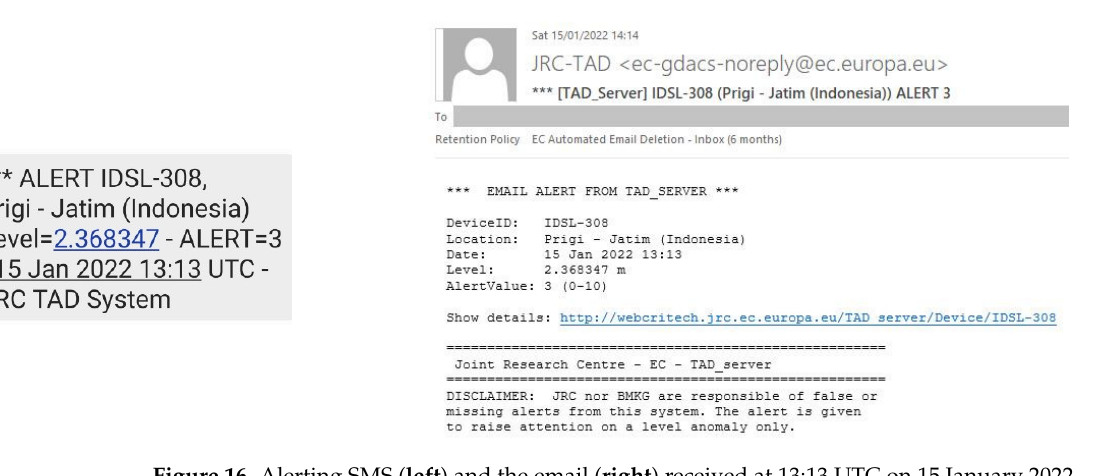
Figure 16. Alerting SMS ( left ) and the email ( right ) received at 13:13 UTC on 15 January 2022.